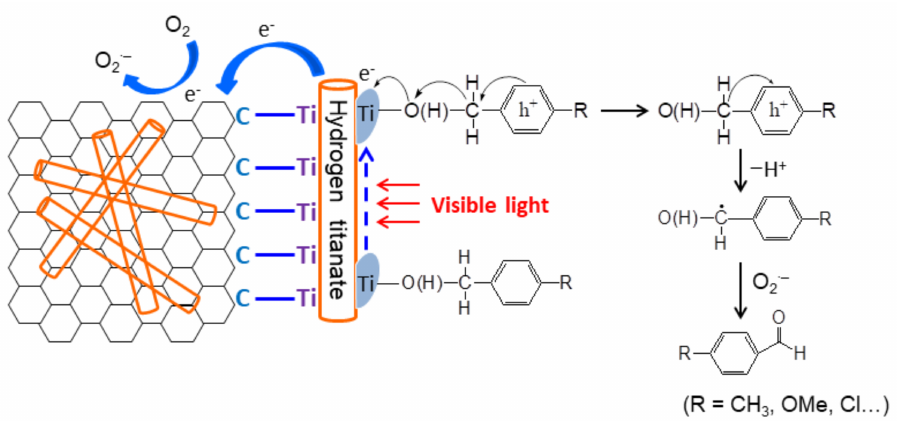
Figure 13. Schematic illustrations for the efficient interfacial charge transfer effect over HTT/graphene composites toward the selective oxidation of benzylic alcohols under visible light